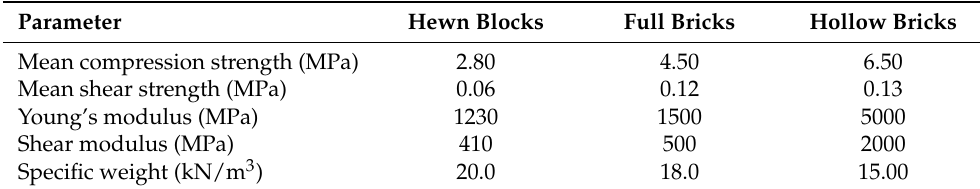
Table 5. Adopted parameters for different masonry